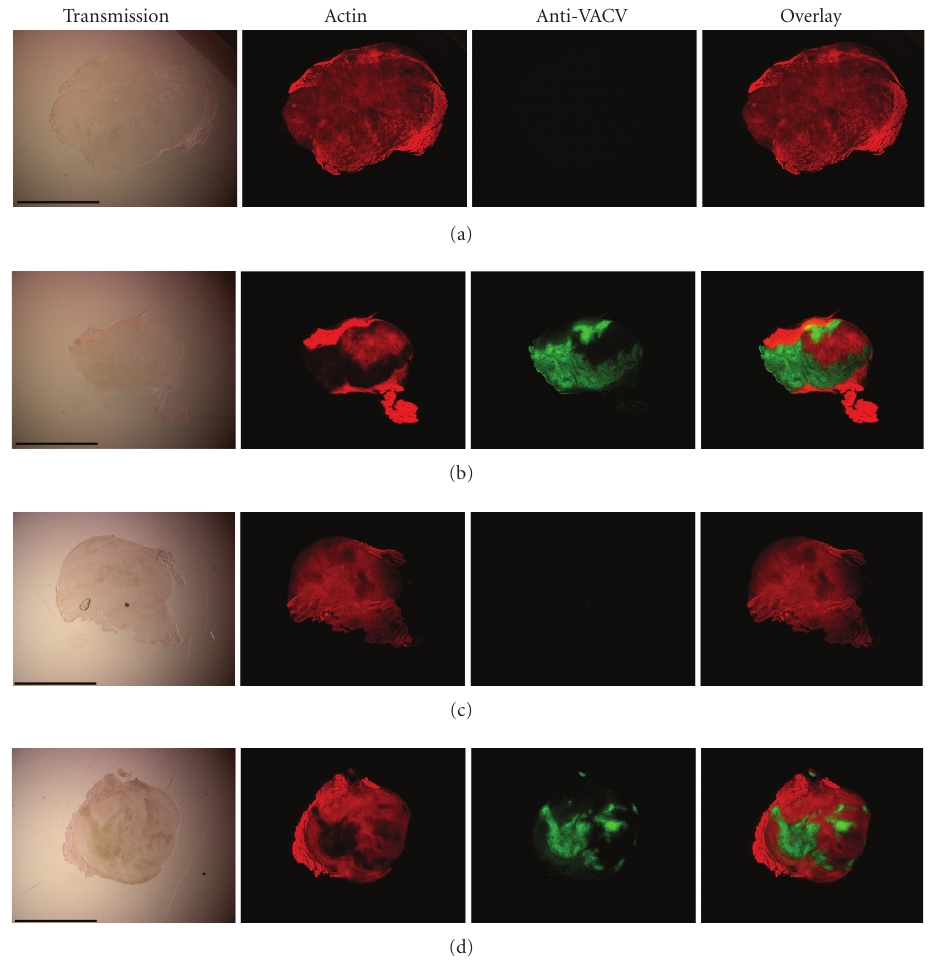
Figure 4: Immunohistochemical staining of PC-3 tumors. Male ((a) and (b)) or female ((c) and (d)) mice bearing PC-3 tumors were i.v. injected either with PBS ((a) and (c)) or with 5 × 10 6 pfu of GLV-1h68 ((b) and (d)). At day 42 after injection, whole tumor cross-sections (100 μ m) were labeled with Phalloidin-TRITC (red) and anti-VACV antibody (green). Scale bars = 5mm.